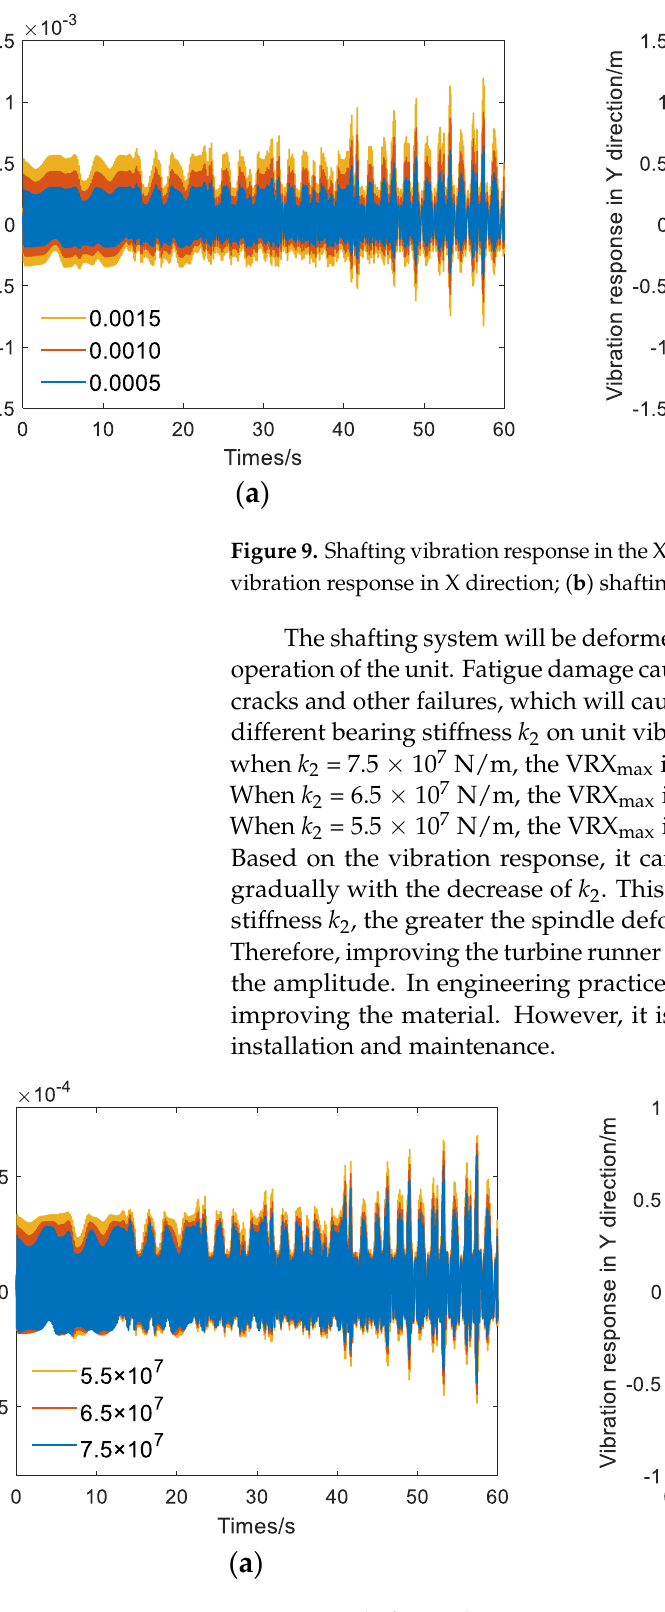
Figure 10. Shafting vibration response in the X and Y directions of the unit with different k 2 ; ( a ) shafting vibration response in X direction; ( b ) shafting vibration response in Y direction. The mass of turbine runner m 2 is usually determined by the material used for casting and the number of the blades. Equipment manufacturers may reduce the blade thickness to improve efficiency and use new materials and coatings to resist cavitation and wear; all of these ways may have an impact on m 2 . From Figure 11, three different runner masses are selected to compare the vibration of the unit. The VRX max is 7.63 × 10 −4 m when m 2 = 1.4 × 10 4 kg and the VRY max is 7.37 × 10 −4 m. The VRX max is 6.06 × 10 −4 m when m 2 = 1.1 × 10 4 kg